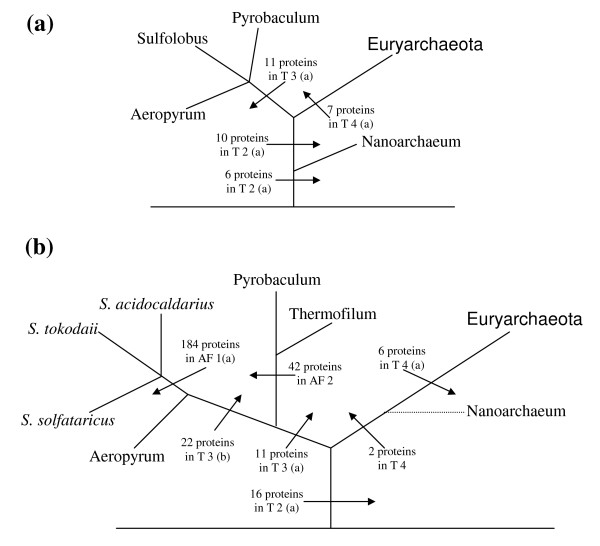
Interpretive diagrams showing the suggested evolutionary stages where genes for some of the signature proteins that are specific for the Crenarchaeota and Euryarchaeota as well as some of the Crenarchaeota subgroups, likely originated. The top diagram (A) indicates the evolutionary interpretation of the signature proteins in the absence of any other information, whereas that below (B) indicates our interpretation of this data taking into consideration other relevant information discussed in the text. The branching pattern shown here is unrooted and the proteins that are shared by all archaea were introduced in a common ancestor of all archaea. The dotted line for N. equitans in (B) indicates that its placement within Euryarchaeota lineage is uncertain. The abbreviations T and AF in these figures as well as others refer to tables and Additional files.